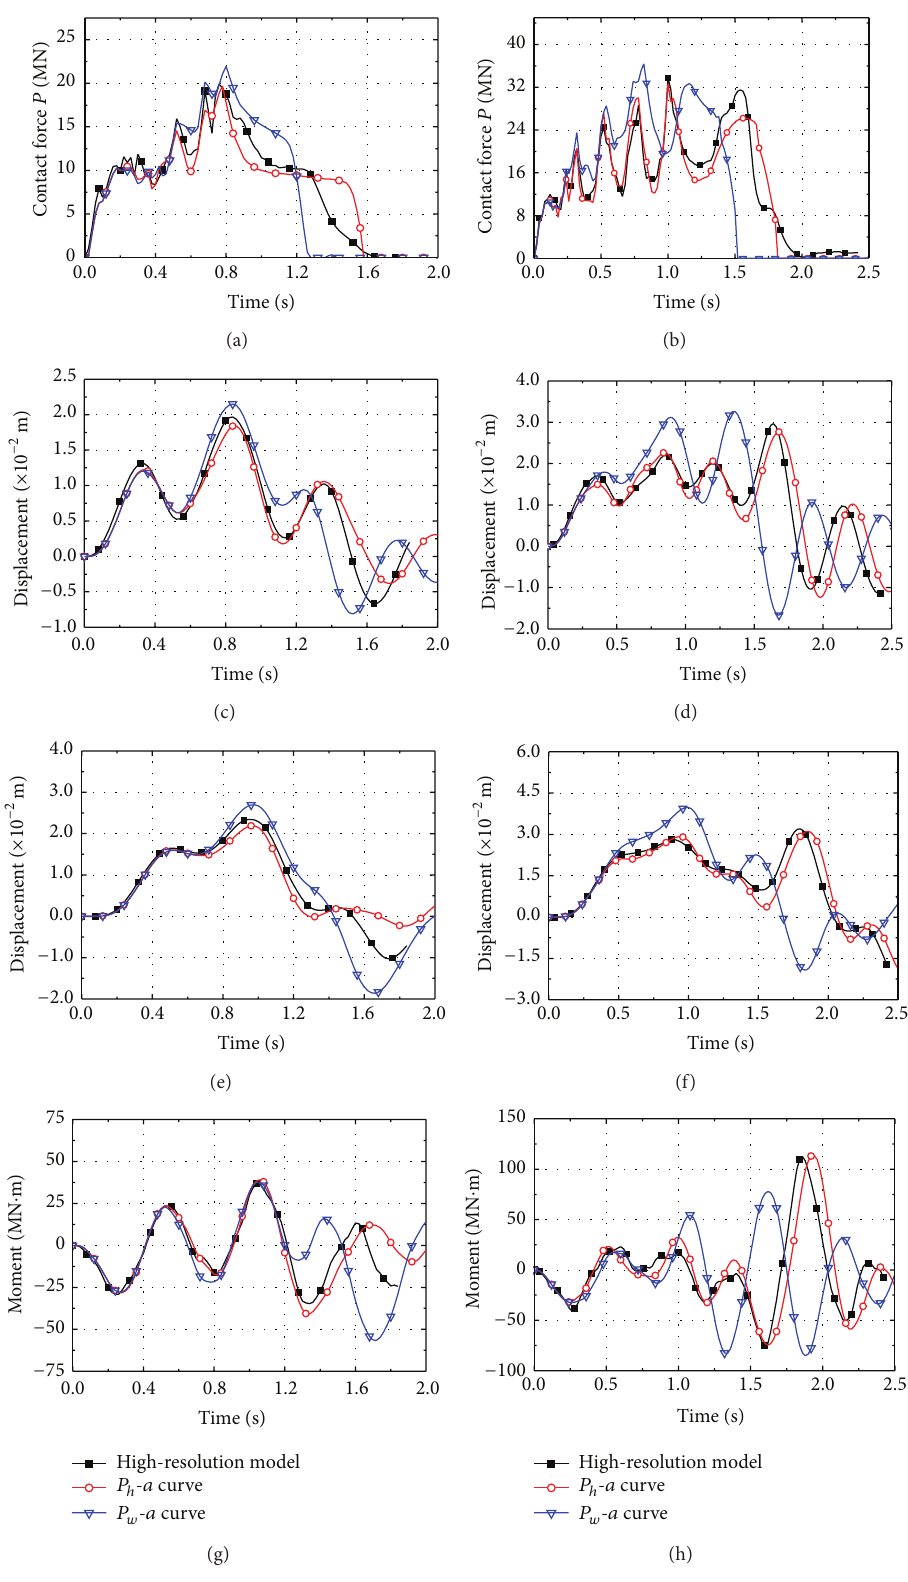
Figure 20: Comparison of the dynamic responses: (a) contact force (2m/s); (b) contact force (4m/s); (c) displacement of pile cap (2m/s); (d) displacement of pile cap (4m/s); (e) displacement of pier top (2m/s); (f) displacement of pier top (4m/s); (g) moment of pier bottom (2m/s); (h) moment of pier bottom (4